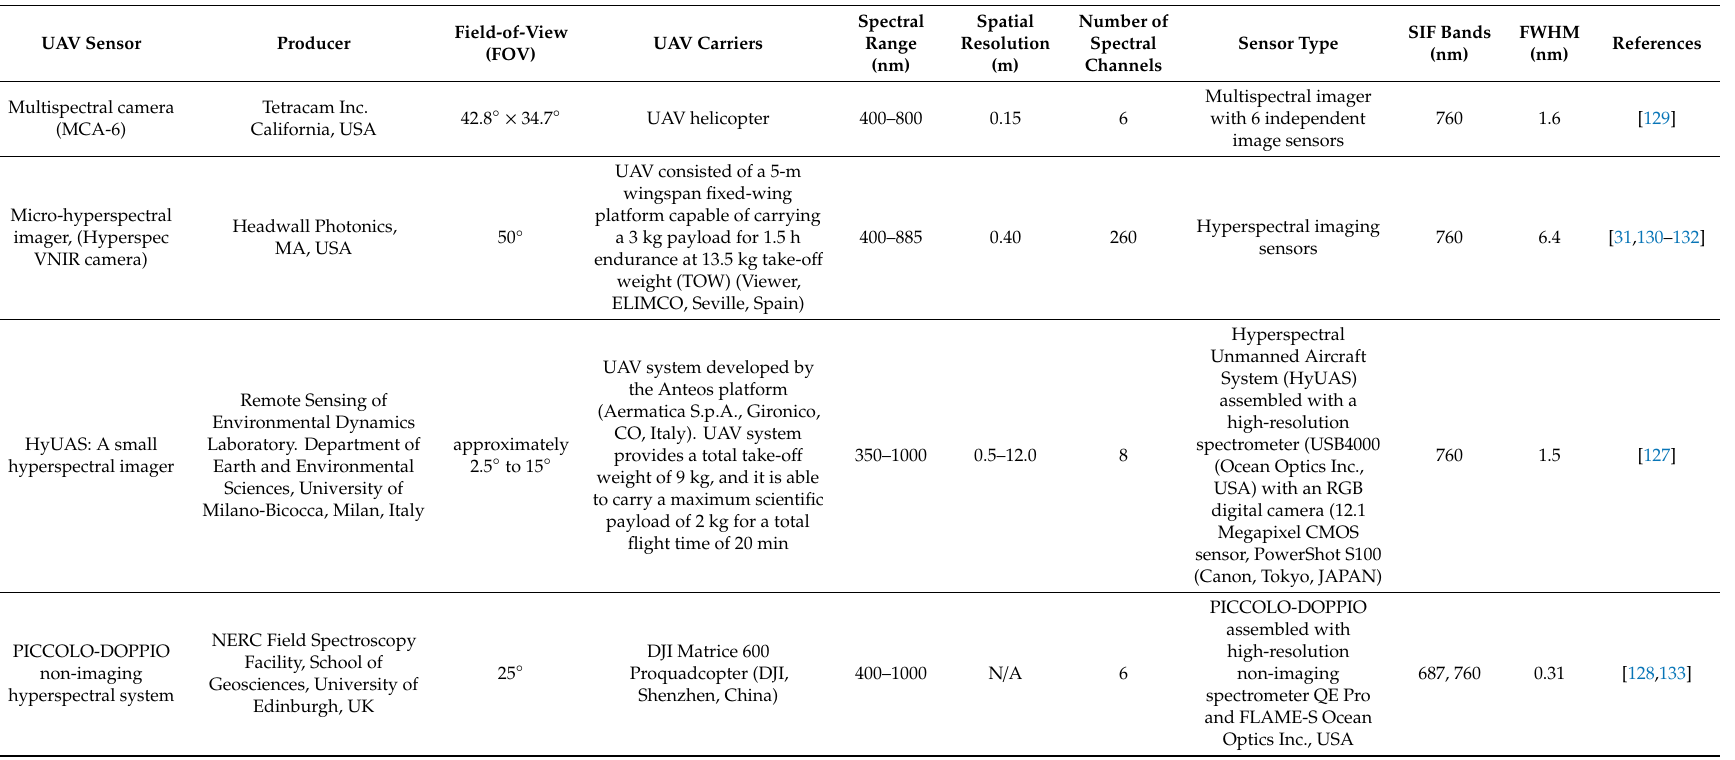
Table 4. Summary of the UAV platforms and systems used for SIF-related studies until